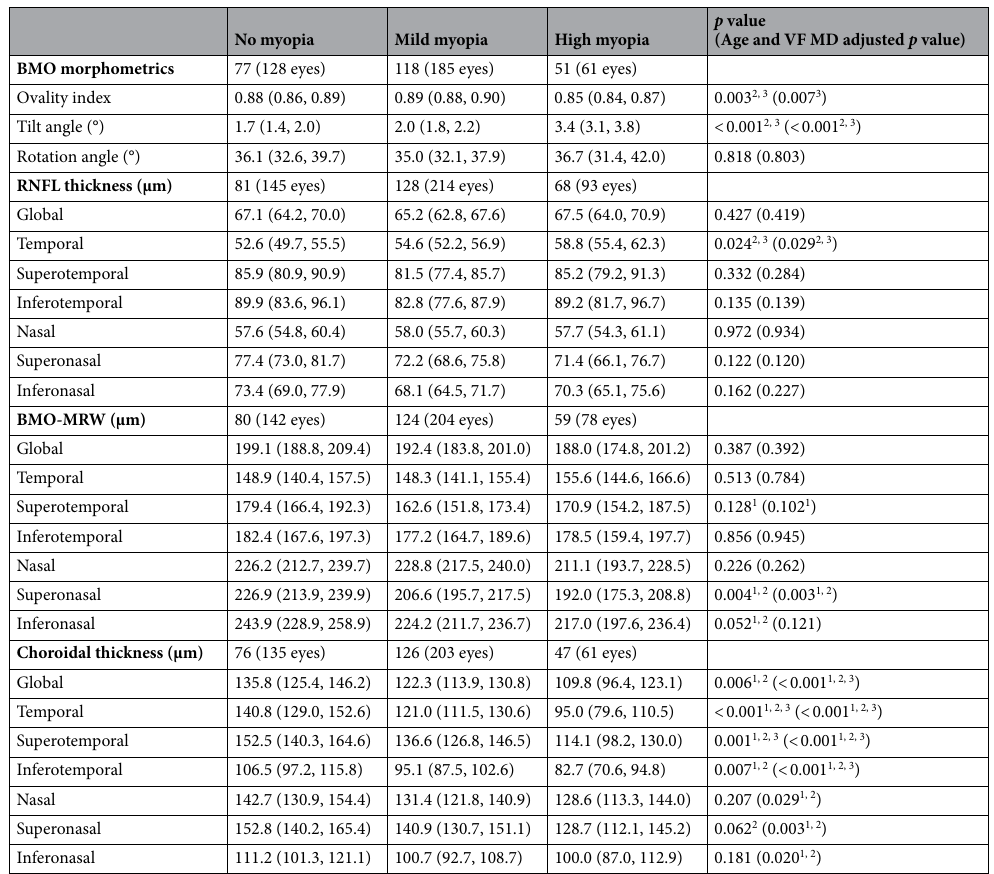
Table 2. Optic disc parameters by myopia group. Results are presented as mean (95% confidence interval). Significance is determined by linear mixed models. No myopia: AL ≤ 24.0 mm; Mild myopia: AL: > 24 mm and ≤ 26.0 mm; High myopia: AL > 26.0 mm. BMO-MRW, Bruch’s membrane opening minimum rim width; ONH, optic nerve head; RNFL, retinal nerve fiber layer; VF MD, visual field mean deviation. 1 No versus Mild Myopia p < 0.05; 2 No versus High Myopia p < 0.05; 3 Mild versus High Myopia p <